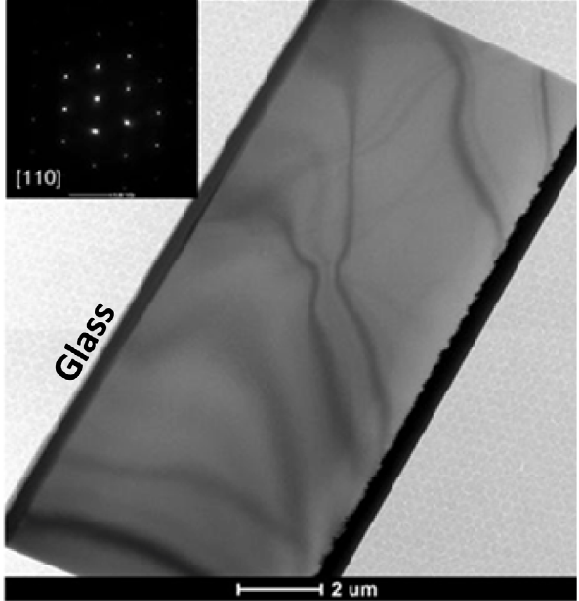
Fig. 2. TEM image and diffraction pattern of defect-free grain with [110] orientation in diode laser crystallised Si film.